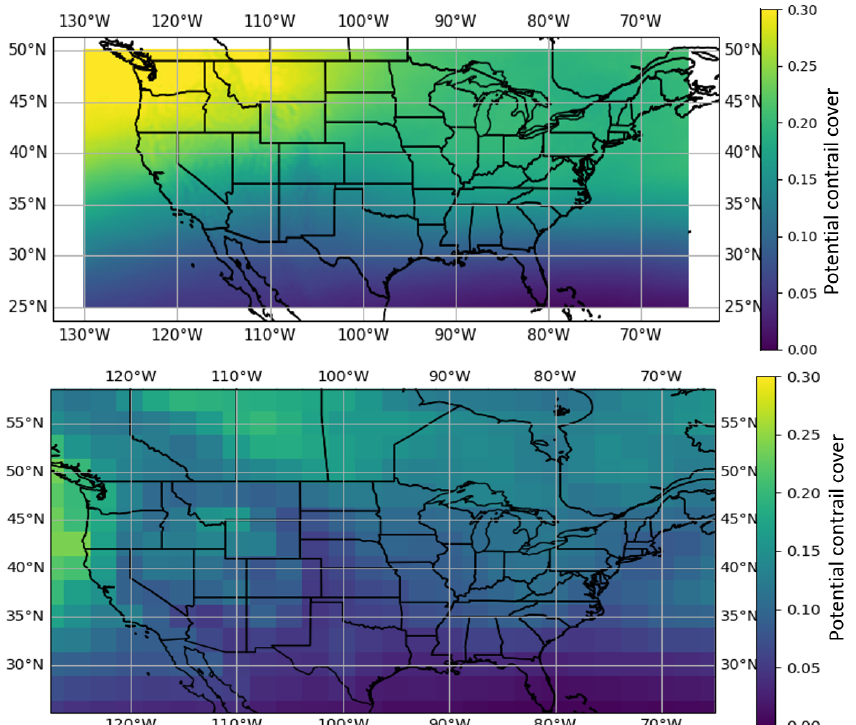
Figure A1. Annual mean potential contrail cover of the years 2010 to 2019 based on the ERA-5 Reanalysis ( top ) and the NCEP/NCAR Reanalysis ( bottom ) over North America at 250hPa pressure level. The panels show clear differences between the models in terms of spatial resolution and potential contrail cover. The latter results from differences in humidity data between ERA-5 and NCEP/NCAR.